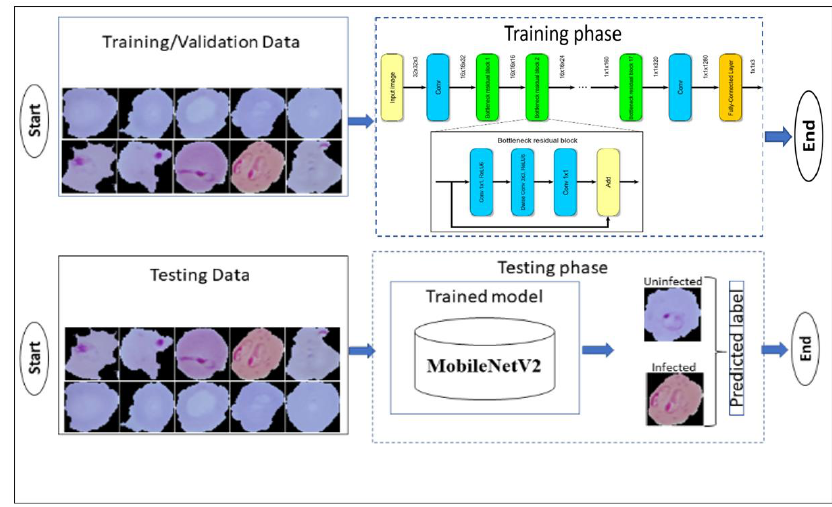
Figure 5. Block diagram of MobileNetV2 model.